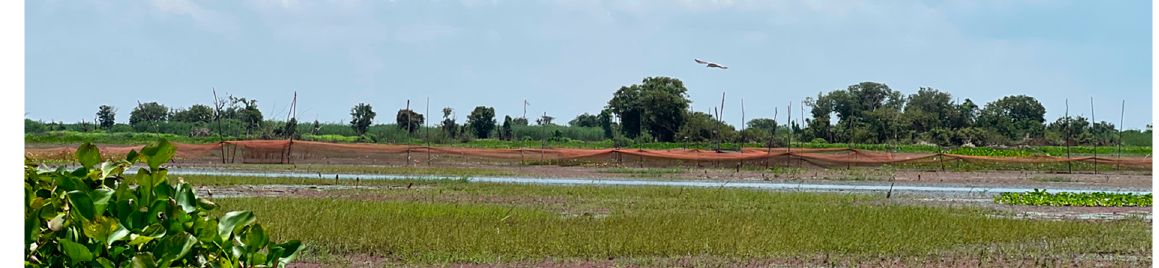
Figure 3. Ecological crisis due to over − exploitation. Abandoned fishing areas and strict control of local activities are consequences of the government’s conservation policy. (Linh Vu, April 2022).